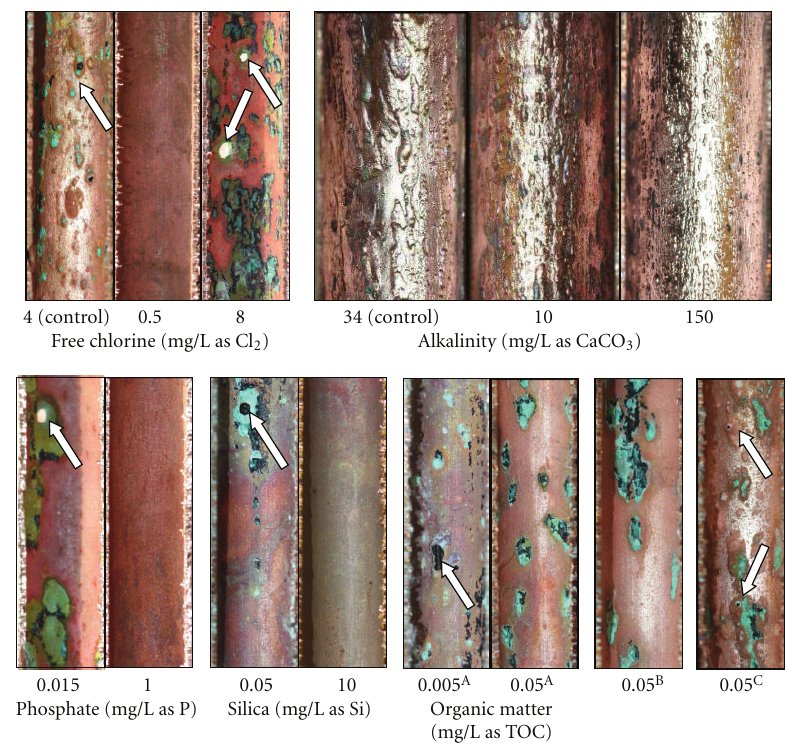
Figure 3: Representative photographs of copper from selected tests following scale removal. Photos are grouped by respective adjustments to control water quality ( A NOM, B ozonated NOM, C sodium acetate/d-glucose), and arrows indicate some of the pinhole leaks that formed during testing. All photos show copper from small-scale tests, except for those in the variable alkalinity group.